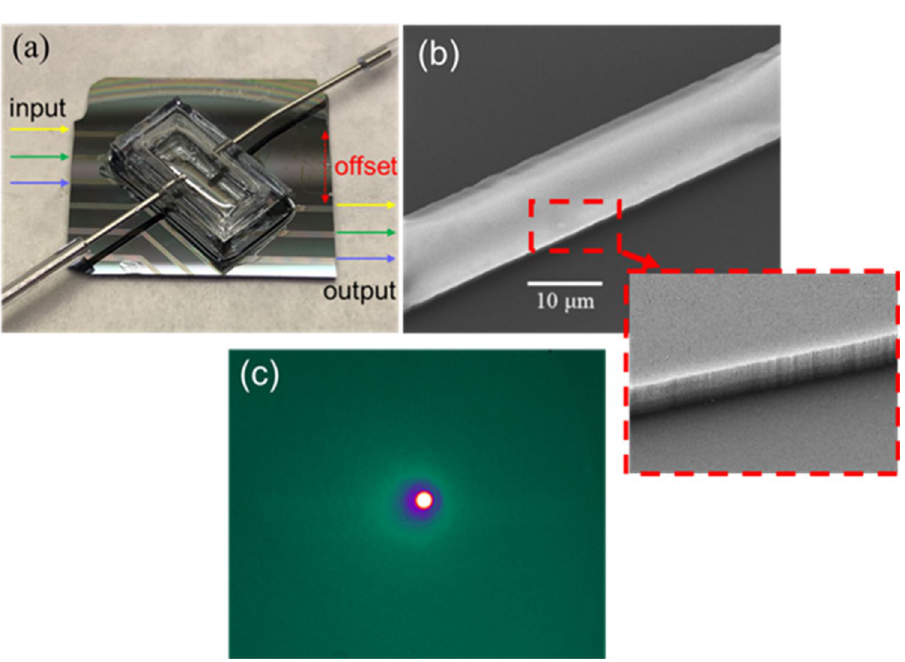
Figure 3. ( a ) Sensor device with SiN waveguides and PDMS chamber. Input and output waveguides were offset by 5 mm. ( b ) SEM top image of a SiN waveguide. The zoom-in tilted image shows its side wall. ( c ) The mode image from a single SiN